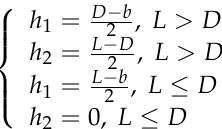
Figure 7. Representative element volume. ( a ) L > D . ( b ) L ≤ D . The thickness of the grout vein is considered to be constant in REV, which is ex- pressed by b . Thicknesses of compacted sand and undisturbed sand are expressed by h 1 and h 2 respectively. Geometric connections among the influence range of grouting, inter- vals of the injection holes and thicknesses of the three regions can be expressed as Equa- tion (3).